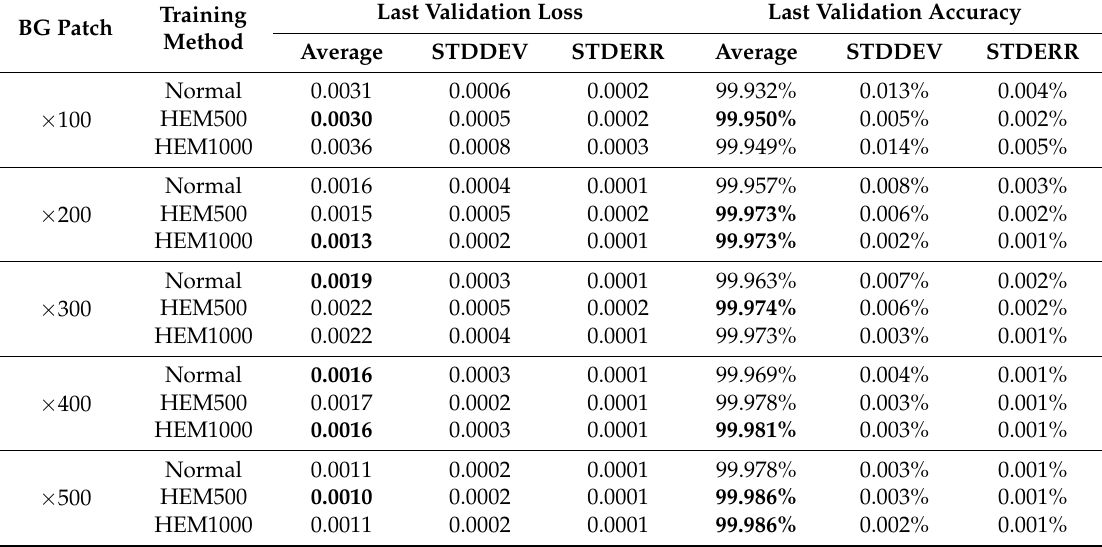
Table 3. Statistics of the last values of validation loss and validation accuracy. We calculated the moving average graphs and averaged the repeated experiments. Here we emphasized the best accuracy among methods in bold font.